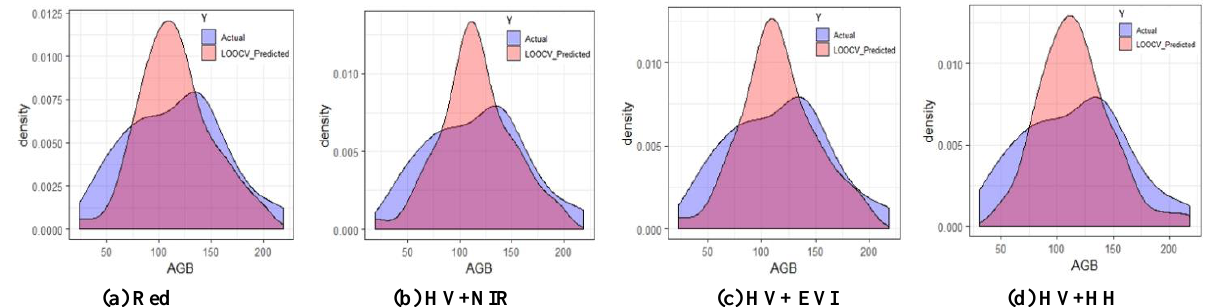
Figure 4. Comparison between the actual aboveground biomass and the predicted aboveground biomass using Leave-one-out cross- validation in different models (a) Red, (b) HV+NIR, (c) HV+EVI, and (d)